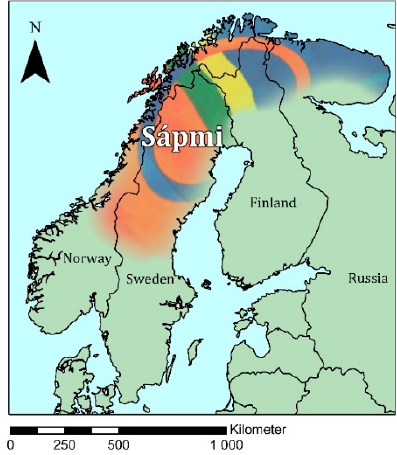
Figure 1. Sápmi, the traditional Sami area. Figure 1. S á pmi, the traditional Sami